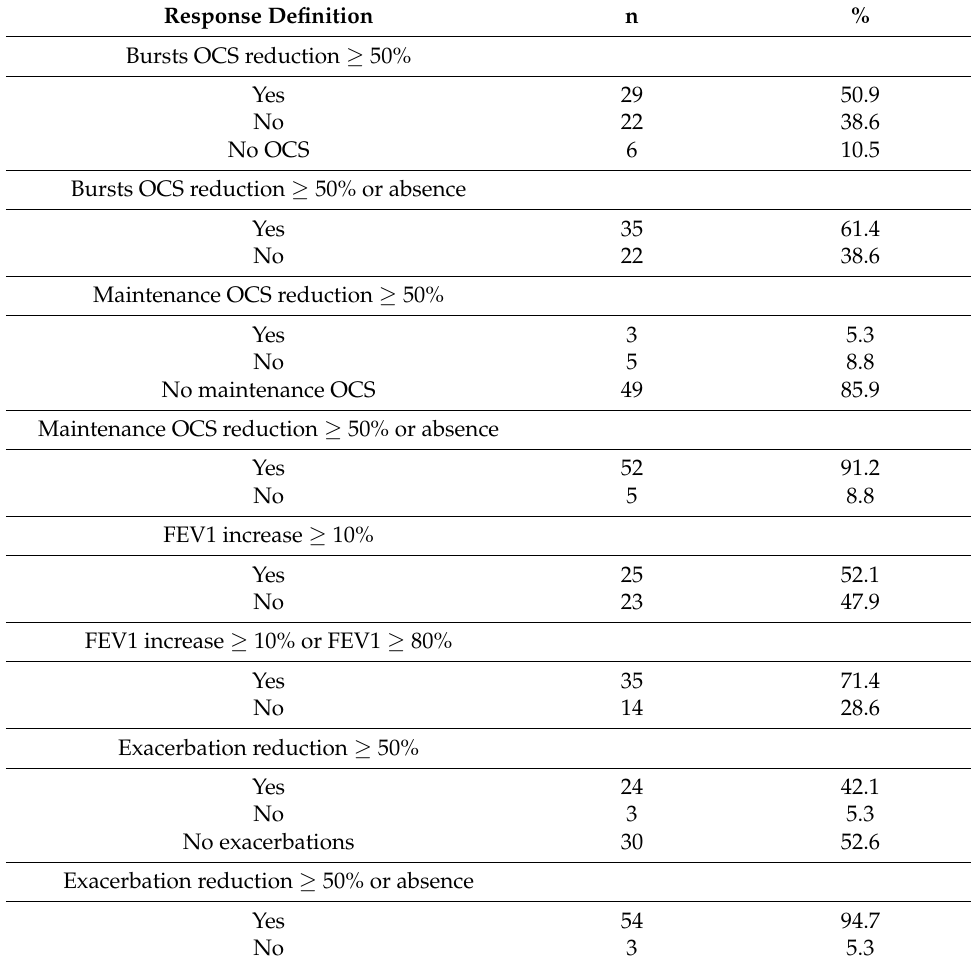
Table 5. Clinical effectiveness of benralizumab in patients with severe uncontrolled